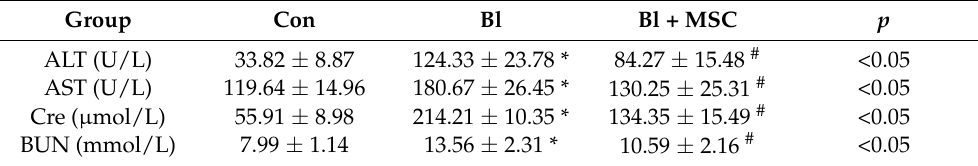
Table 1. Blood biochemistry measurements of liver and kidney damage markers.